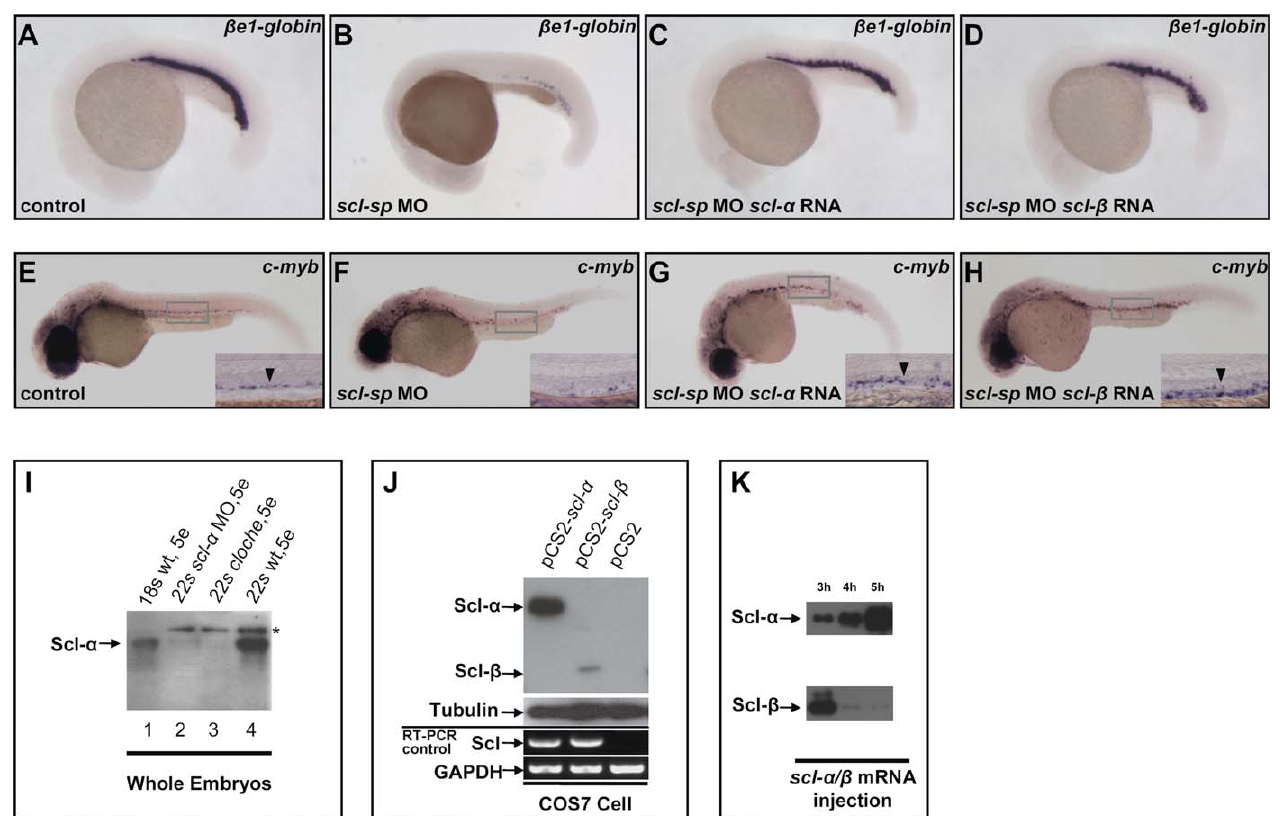
Figure 7. Differences in Protein Expression Levels of Scl- a and - b Confer Their Distinct Functions (A–H) b e1-globin and c-myb expression in scl-sp morphants is rescued by scl- a and - b mRNA. (A–D) show WISH of b e1-globin in 20-hpf control embryos (A), scl-sp morphants (B), scl-sp morphants injected with scl- a mRNA (C), and scl-sp morphants injected with scl- b mRNA (D). (E–H) show WISH of c-myb in 30-hpf control embryos (E), scl-sp morphants (F), scl-sp morphants injected with scl- a mRNA (G), and scl-sp morphants injected with scl- b mRNA (H). Insets in (E–H) are high-magnification (20 3 ) views of the ventral wall of DA, indicated by black arrowhead. In all panels, embryos are in lateral view with anterior to the left. (I) Immunoblotting with Ab-Scl-C antiserum shows the expression levels of Scl- a and Scl- b proteins in wild-type (wt) embryos, clo mutant embryos, and scl- a morphants. Although Scl- b protein was not detectable, immunoblotting of whole embryo protein extracts (50 l g for each sample) showed that Scl- a protein expression increased as embryos developed from the 18-somite (lane 1) to 22-somite (lane 4) stage. The clo mutant embryos (lane 3) and scl- a morphants (lane 2), in which Scl- a protein was not detected, were used as the controls to distinguish the Scl- a protein (arrow) and nonspecific band (asterisk). (J) Immunoblotting with Ab-Scl-C antiserum shows the expression levels of Scl- a and Scl- b proteins in transfected COS7 cells. Western blotting of whole cell protein extracts (10 l g for each sample) prepared from COS7 cells transfected with full-length scl- a , scl - b , or blank vector constructs revealed that the protein level of Scl- a was much higher than that of Scl- b . RT-PCR analysis (bottom) showed similar RNA levels of scl- a and - b in these transfected cells. Tubulin and GAPDH were used as controls for Western blot and PCR, respectively. (K) Immunoblotting with Ab-Scl-C antiserum shows the expression levels of Scl- a and Scl- b proteins in the embryos injected with in vitro synthesized scl- a or - b mRNA. Western blotting of whole embryo protein extracts (50 l g for each sample) from embryos injected with 500 pg of scl- a or - b mRNA showed that, at 3 h post-injection, the Scl- b protein was detected as being at a comparable level to that of Scl- a but dramatically reduced by 4 h post-injection.